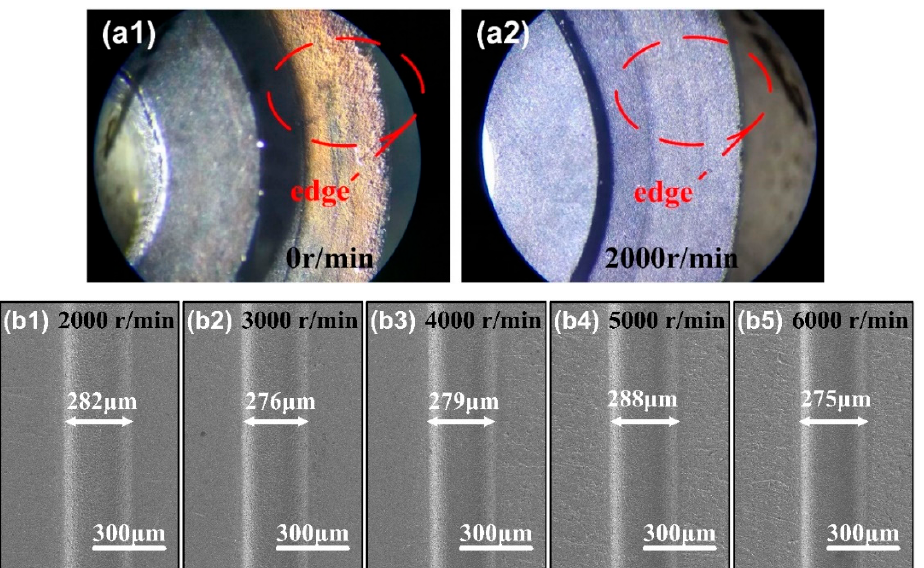
Figure 7. ( a1 , a2 ) Photographs of thin edge surfaces after ECM milling for 30 min with the rotate speed of 0 r/min and 2000 r/min under optical microscope. ( b1 – b5 ) SEM images of micro-grooves under the disk electrode rotate speed of 2000 r/min, 3000 r/min, 4000 r/min,5000 r/min and 6000 r/min.